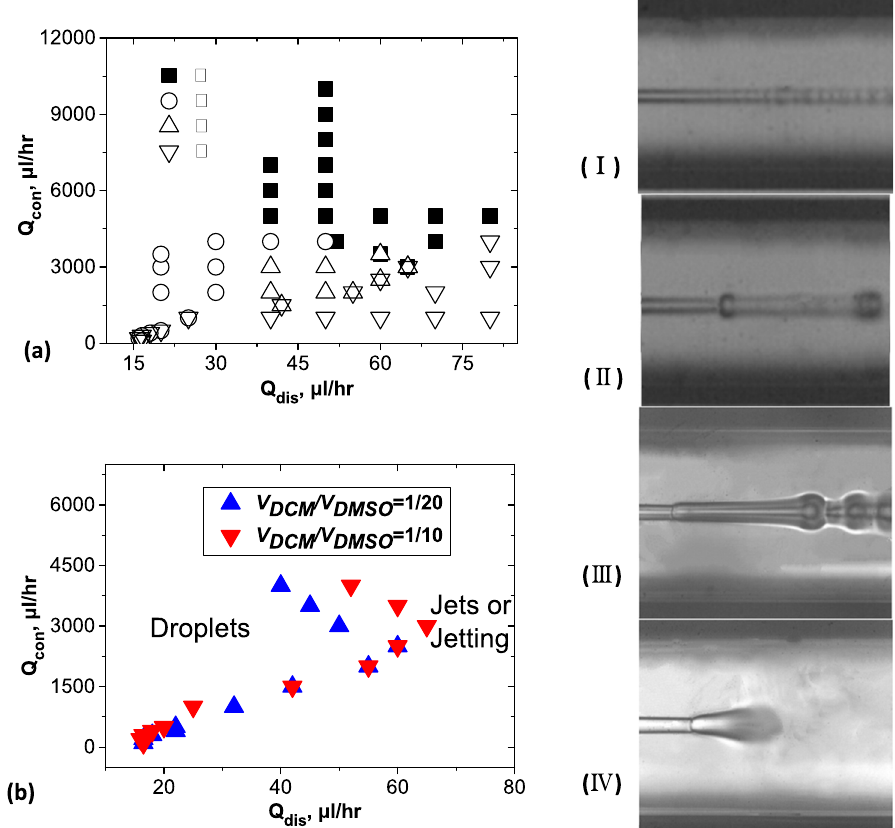
Figure 2. ( a ) Map of flow behavior in the (Qcon, Qdis) plane for fixed V DCM / V DMSO = 1/10. Optical microscopy images (height: 870 µ m) show different forms of the jet. Thin jets broke into tiny droplets at a well-defined location (I, solid squares). Other regimes led to droplets with periodic modulations: droplets with a diameter smaller than twice the nozzle size (II, open circles), and droplets with a diameter larger two times the nozzle size (III, open triangles). Finally, wide straight jets were stable at nozzle, and then diffused within water through the channel (IV, open inverted triangles). ( b ) Boundaries between droplets and jets shifted as the V DCM / V DMSO was changed. Concentration of PLGA (Mw = 4000~15000 g/mol) = 5 mg/mL, in two DCM/DMSO mixtures (1/10 and 1/20 v/v ). The boundaries of the flow diagram depend slightly upon the history of the experiment and upon the experiments. This explains why in some situations, we have reported two symbols for a given experimental